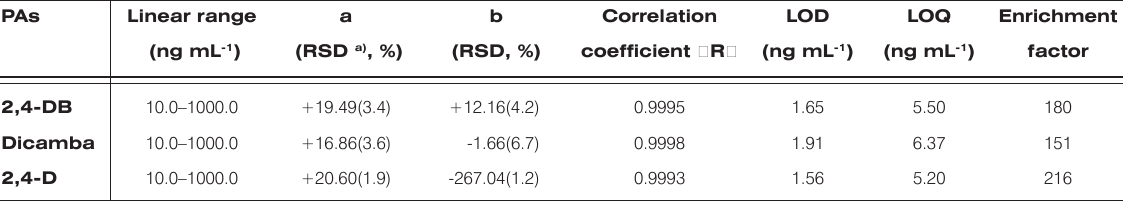
Table 1. Linear range, regression data, concentration limits and enrichment factor for the PAs. PAs